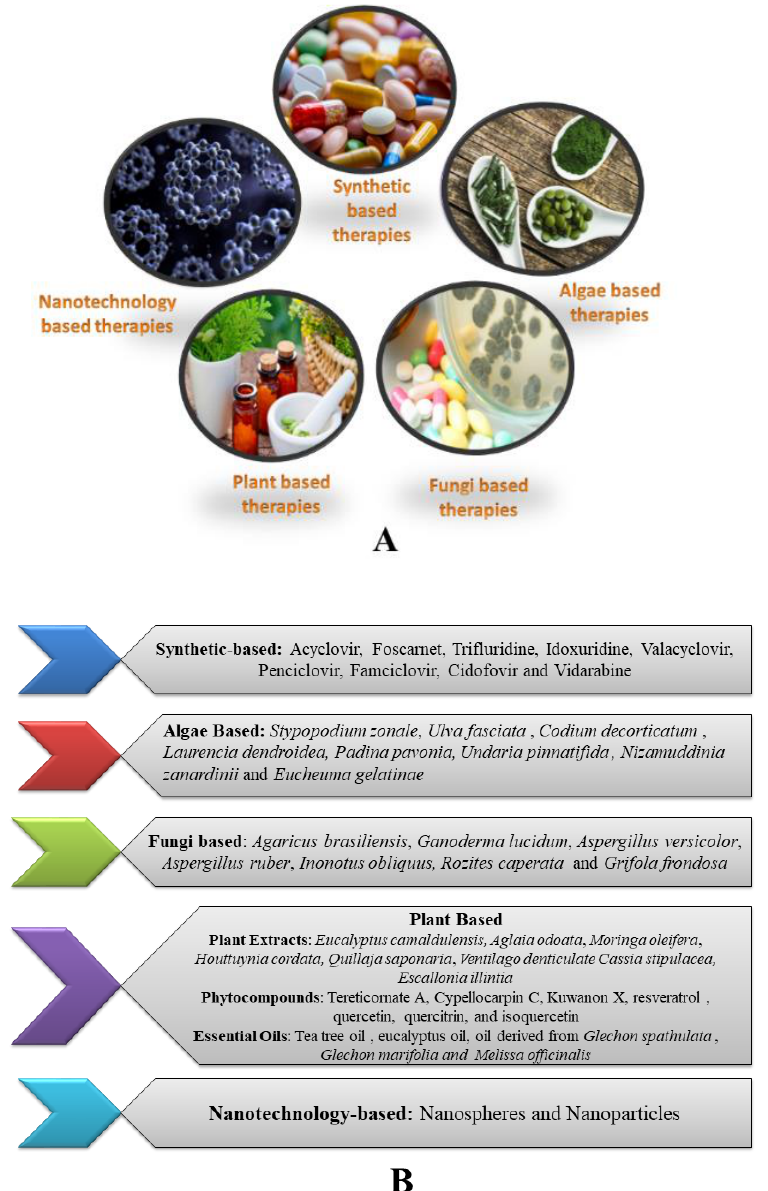
Figure 2. ( A ): Various therapeutic strategies for the treatment of HSV infection; ( B ): Examples under different categories of HSV therapeutic strategies.